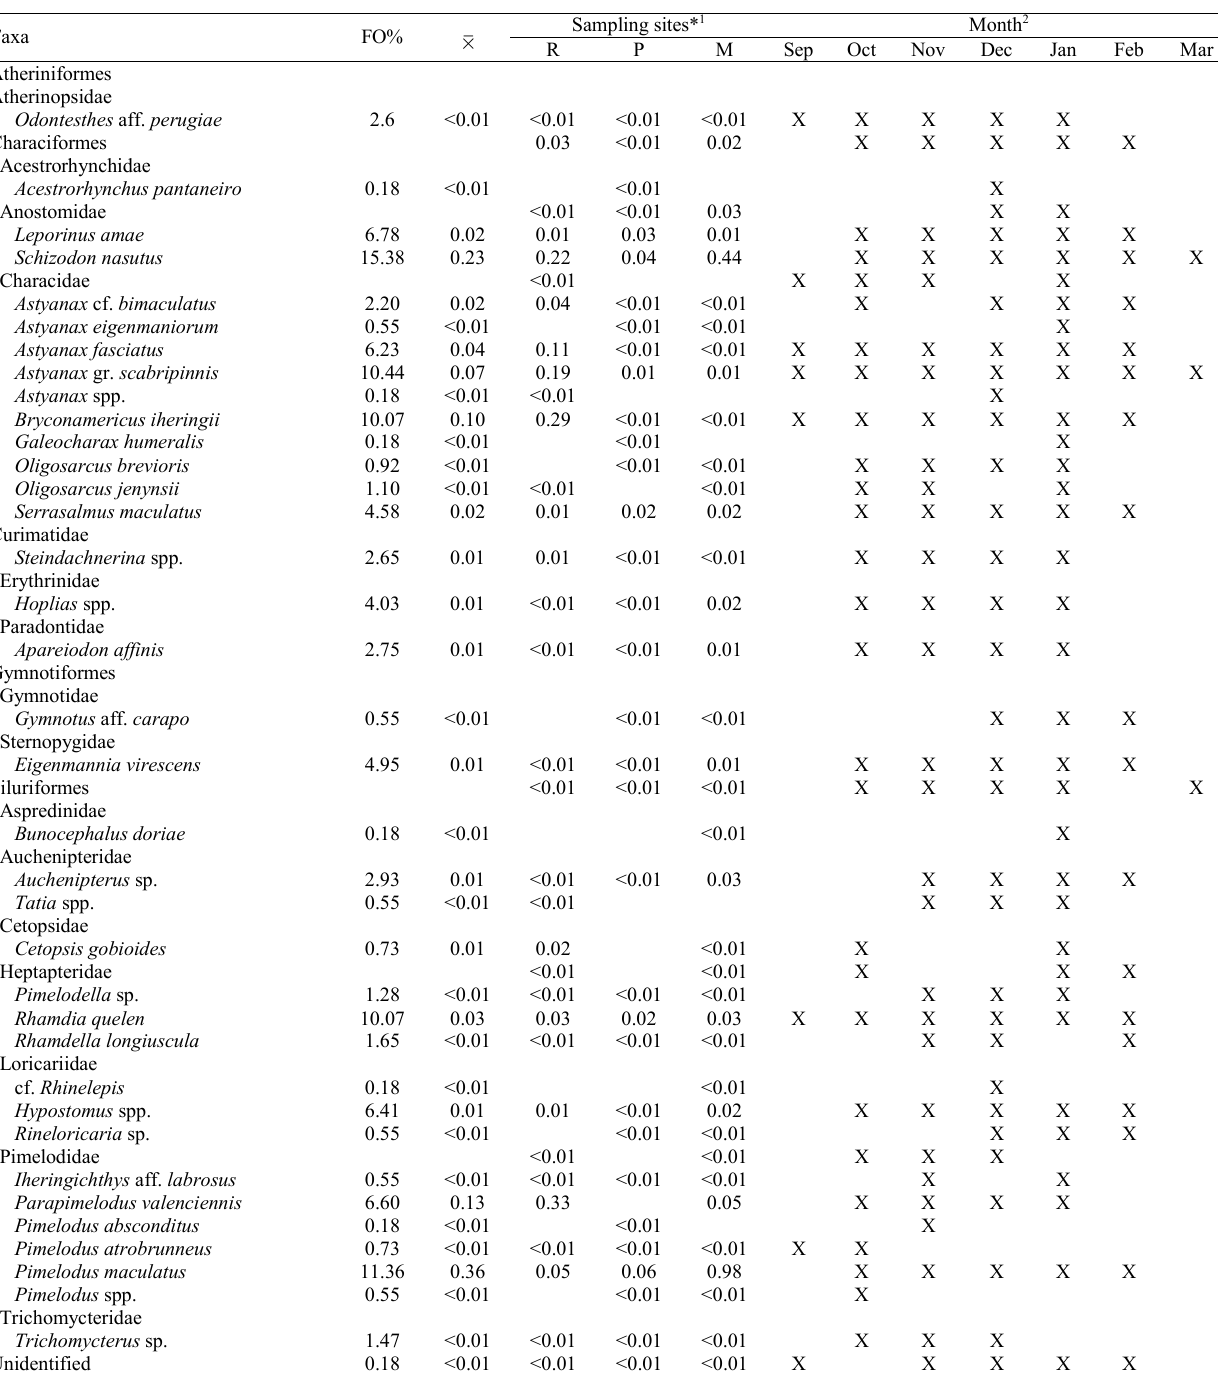
Table 1. Composition, frequency of occurrence (FO%) and average density (0) (individuals/10 m³) of fish larvae during the different months and sampling sites at the Ligeiro River between September 2006 and March 2007. 1- Type of environment; R - rapids; P - pool; M - river mouth; 2 - X- indicates that the species was captured during the marked months; *Less than 0.01 individuals/10 m 3